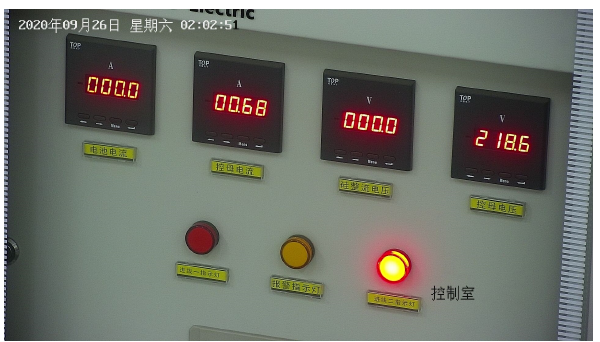
Figure 6. Original image